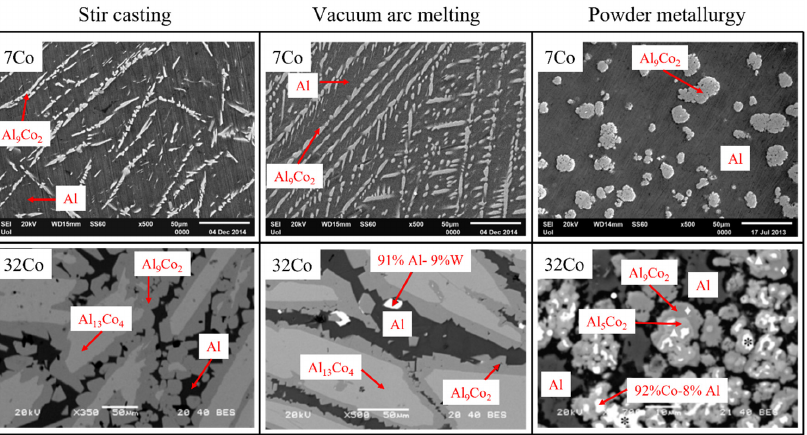
Figure 2. SEM images (backscattered electron mode) for Al-7 wt % Co (7Co) and Al-32 wt % Co (32Co) fabricated by stir casting, vacuum arc melting and powder metallurgy (Reprinted with per- mission from [34,72]. Copyright 2022, Elsevier).